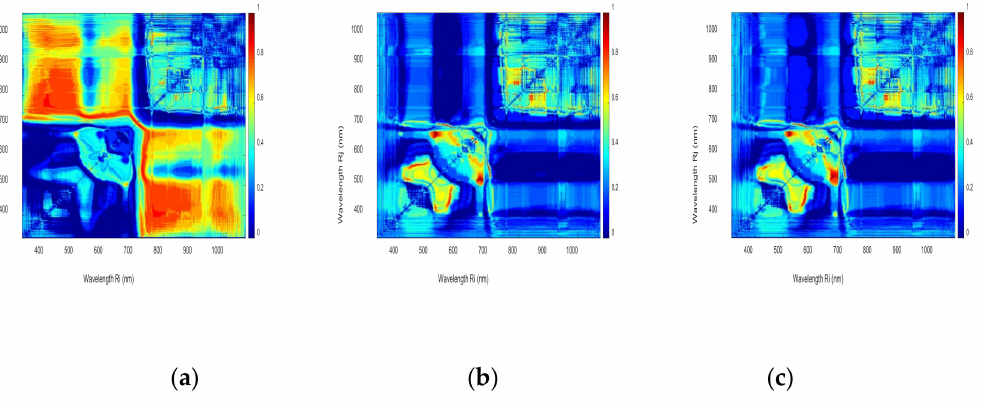
Figure 2. The contour map of KI for the two-band combinations ( a ) RDSI, ( b ) RNDSI, ( c ) RRSI. Among the three types of reconstructed two-dimensional SIs, the maximum KI of RDSI was 0.935, six pairs of red side band combinations were all reached 0.935; RDSI (R702, R715) were taken as the sensitive RDSI of cotton aphid stress, 702 and 715 nm were both in the red edge region. For RNDSI and RRSI, the kappa coefficient of most band combinations was below 0.7, while the KI of some band combinations in the 490–730 nm region reached the maximum of 1. The contour map of RNDSI was similar to that of RRSI. The number of band combinations whose KI value reached 1 was 96 and 61 for RNDSI and RRSI, respectively. Due to multiple band combinations with the maximum KI, according to Equation (10), the maximum band combinations RNDSI (R643, R656) and RRSI(R656, R643) were taken as the sensitive two-band indices of cotton aphid stress; RNDSI and RRSI had the same sensitive spectrum consisting of 643 and 656 nm, which were in the red